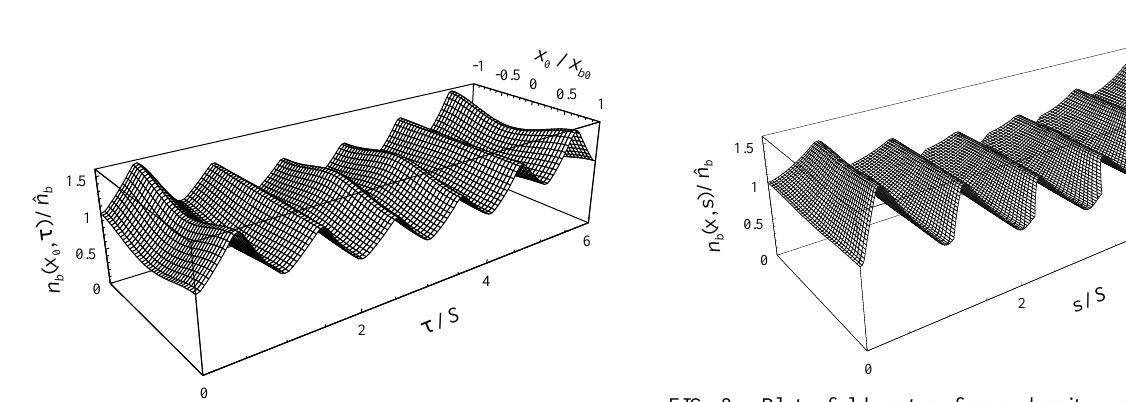
FIG. 8. Plot of laboratory-frame density profile n b (cid:1) x , s (cid:2) (cid:1) n b (cid:4) x 0 (cid:1) x , s (cid:2) , s (cid:5) obtained numerically from Eqs. (82)–(86) and Eq. (94) for the initial density profile in Eq. (90) and choice of system parameters in Eq.